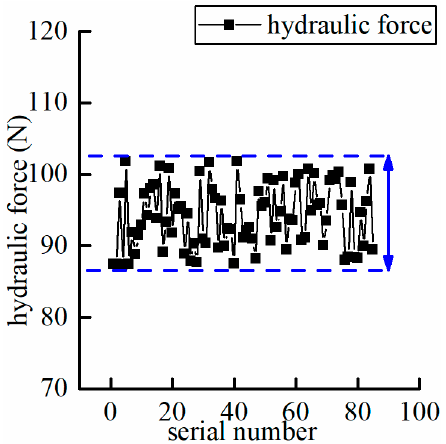
Figure 14. Pareto optimal solutions of hydraulic force.